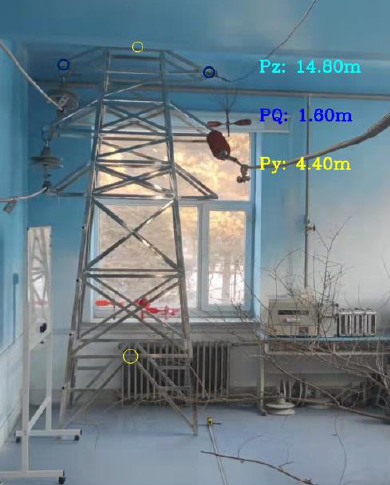
Figure 12. Position and distance results. Table 1. Indoor test camera detection